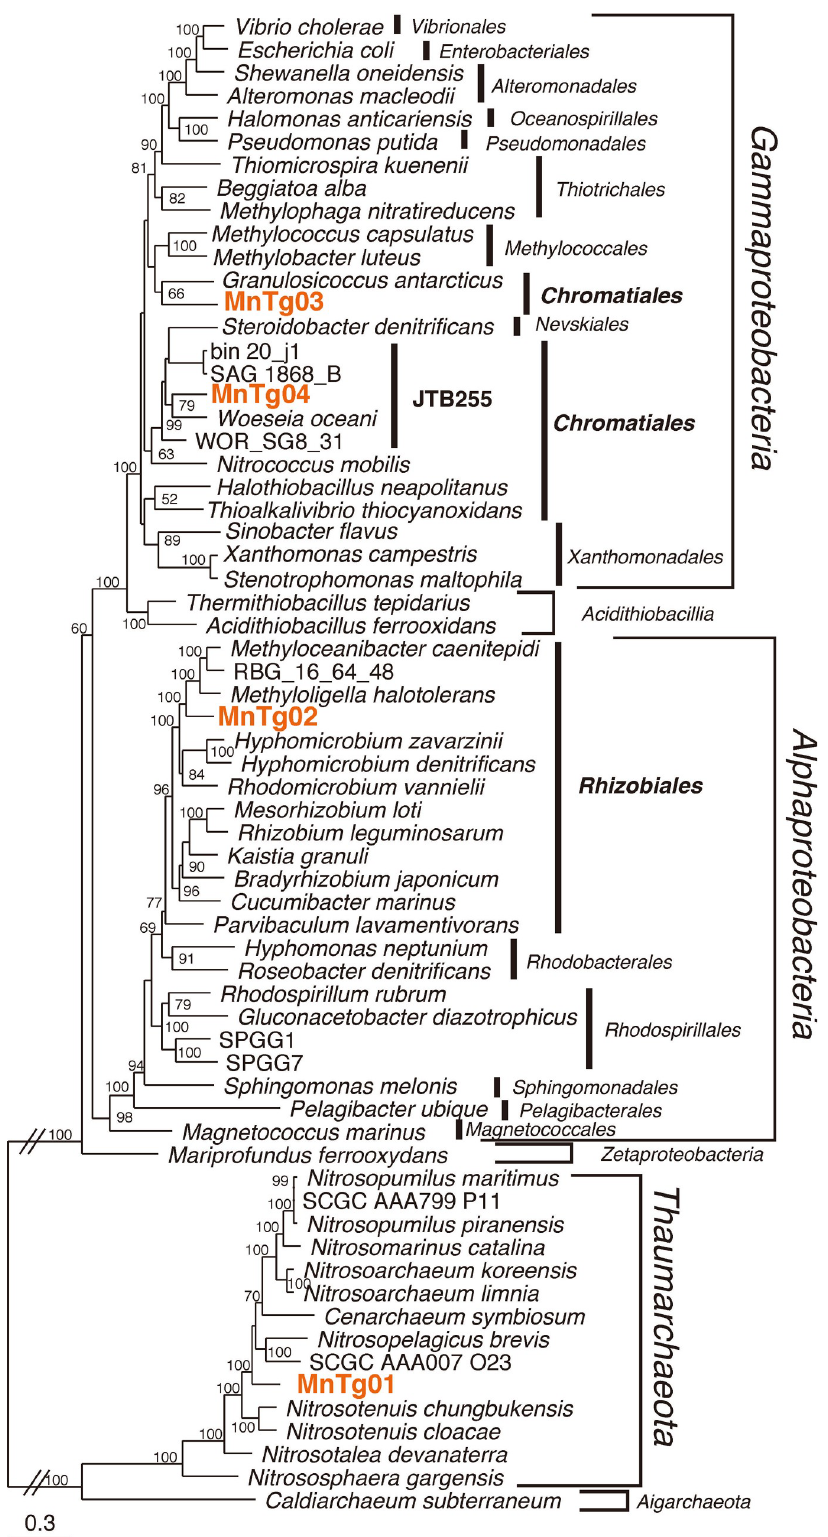
Fig 5. Phylogenomic tree for the MAGs. The maximum-likelihood tree of the MAGs was constructed using 43 conserved single-copy marker proteins. The IDs in bold and orange were reconstructed in the present study. Accession